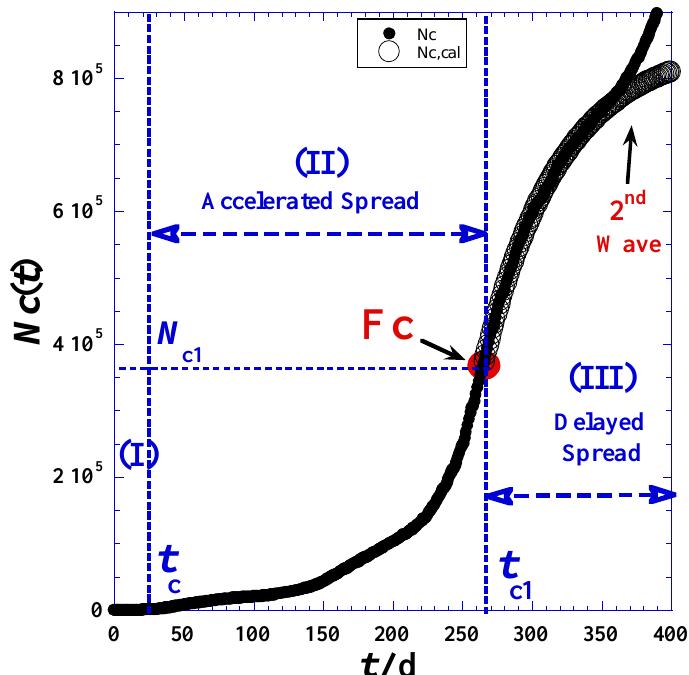
Figure 7. Total reported cases Nc ( t ) of the first 400 days for delayed phase (III) in asymmetric behavior using Equation(16) with τ c ’= 56 days and N c∞ = 753,500.